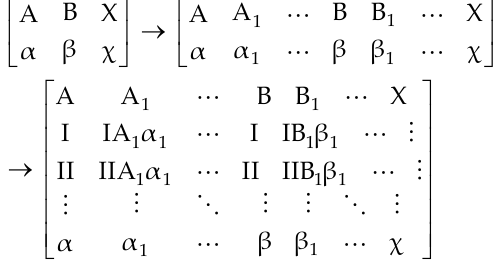
Figure 3. Schematic diagram of interpolation node.